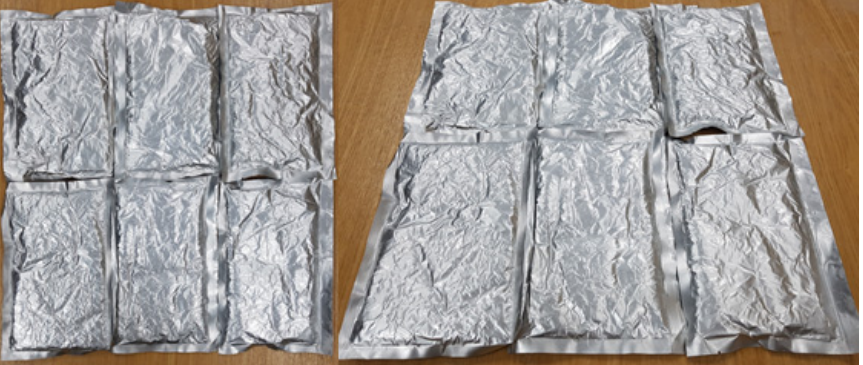
Figure 9. Images of the PCM packaging.